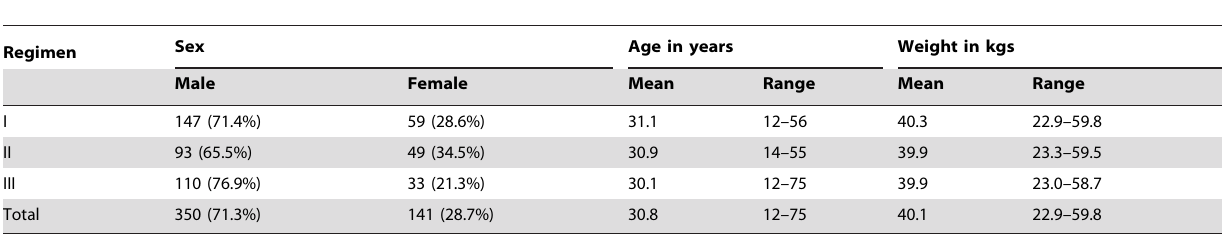
Table 1. Base line characteristic of the TB patients.